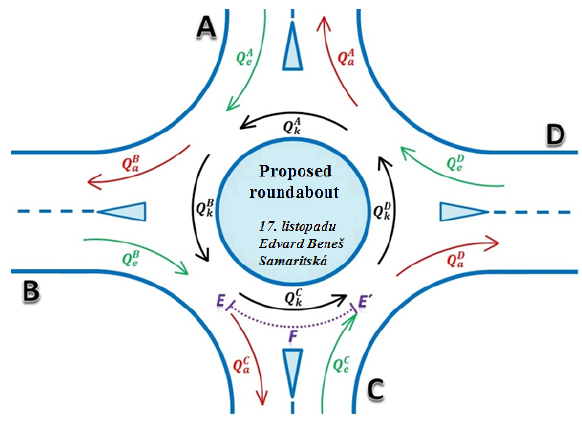
Figure 1: Scheme of the proposed roundabout. Source: authors, [12] used as a guide.